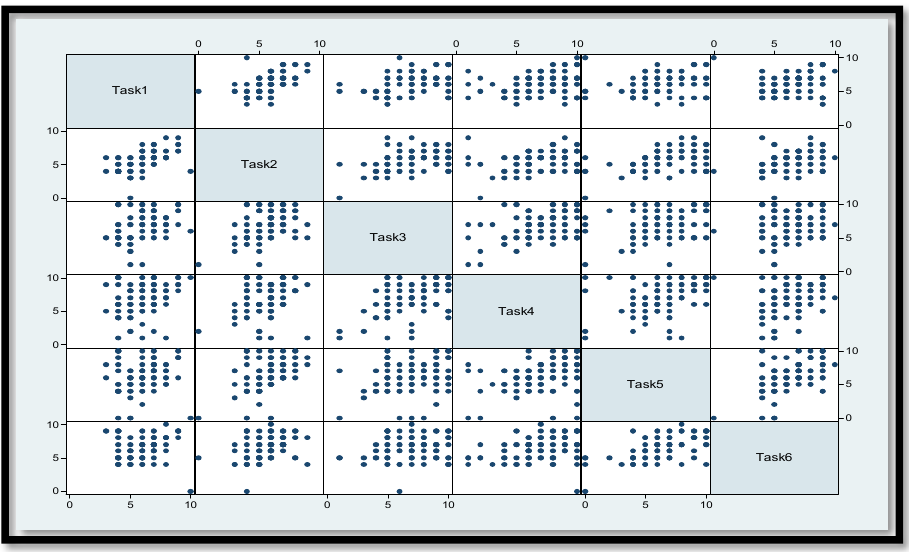
Figure 4. The scatter plot matrix of the choices made by the subjects.